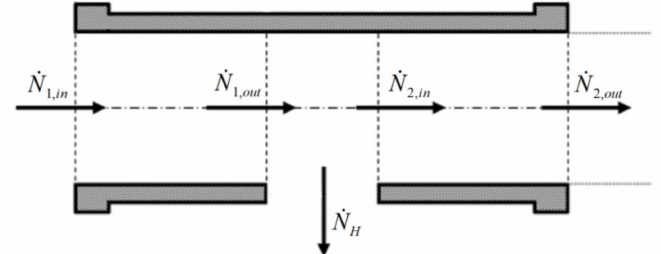
Figure 5. Gas leakage of heat